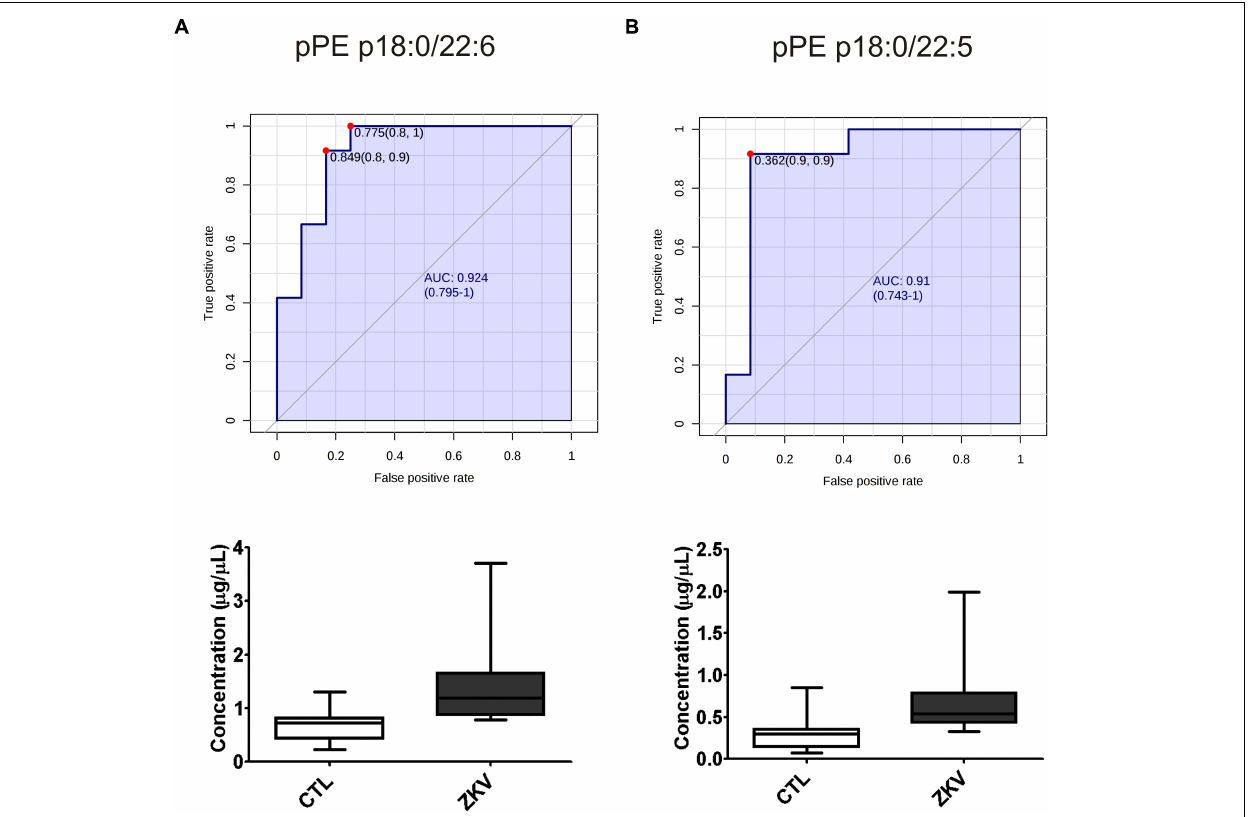
FIGURE 4 | Receiver operating characteristic (ROC) curves and serum concentration of the top 2 pPE lipid molecular species significantly increased in ZIKV-infected patients. pPE p18:0/22:6 (A) pPE p16:0/22:5 (B) using AUC > 0.9 with a 95% interval confidence for comparing ZIKV patients and control groups. The ROC curve analysis of potential biomarkers was calculated with Youden’s index. ROC analysis was performed without log 10